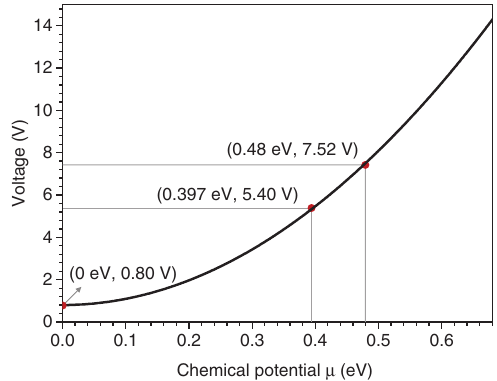
Figure 5: Attenuation of graphene-based polarization-insensitive optical modulator versus incident light wavelength for two sup- ported TM and TE polarized modes.